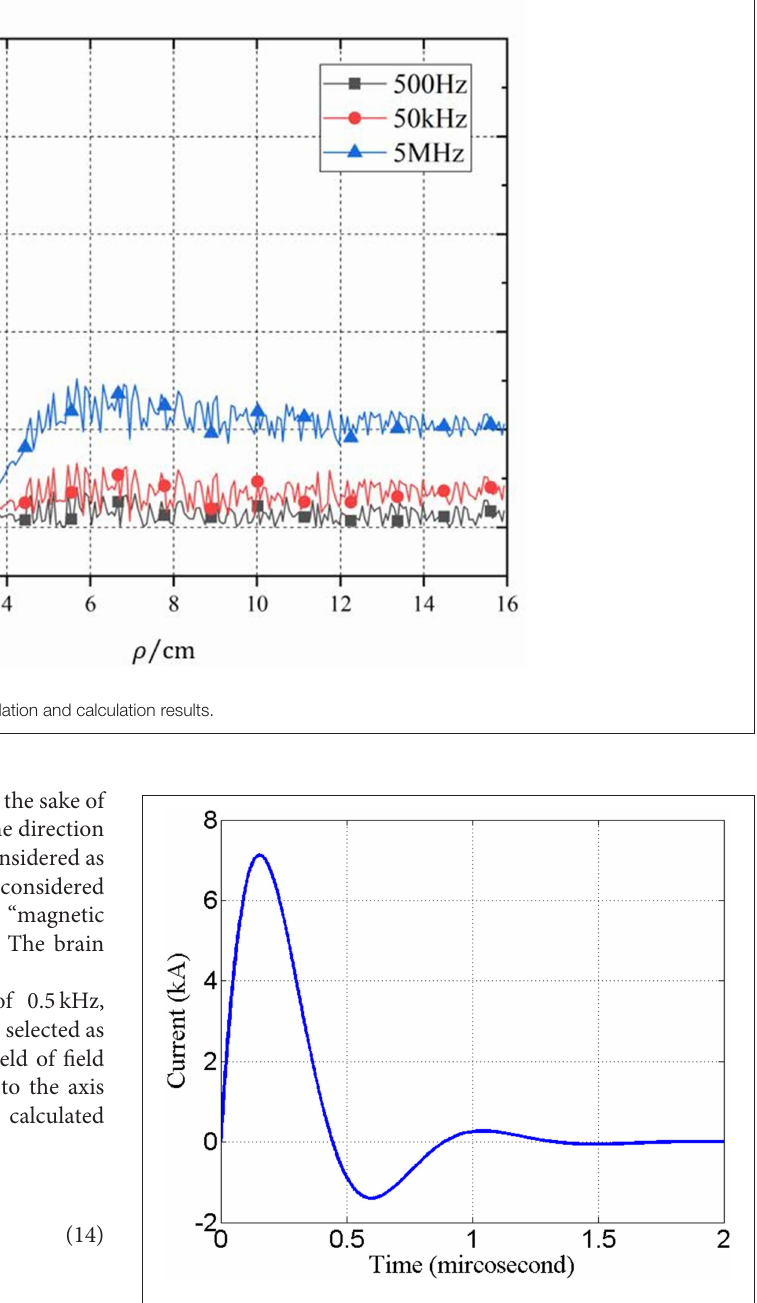
The current rTMS system can be regarded as the sequential expansion of the induced electric field generated by under- damped discharge of multiple RLC circuits in time